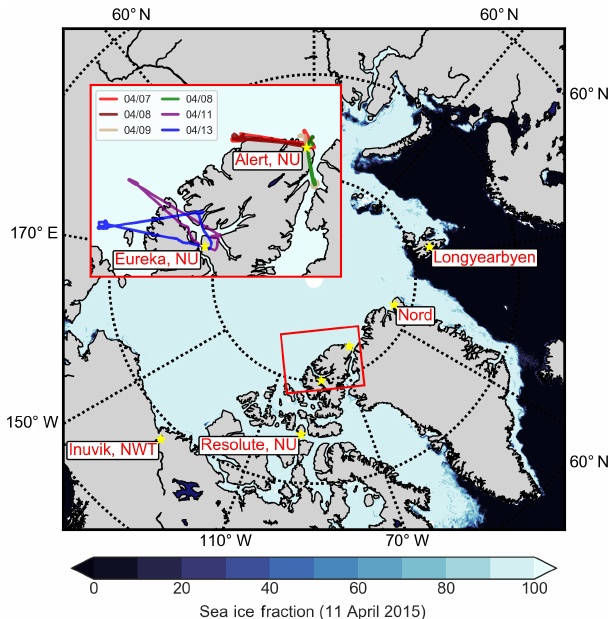
Figure 1. Map of the NETCARE 2015 campaign study area, show- ing sea ice concentrations on 11 April 2015 (Spreen et al., 2008). All stations along the NETCARE/PAMARCMiP 2015 track are shown with yellow stars (Longyearbyen, Svalbard; Alert, Nunavut; Eu- reka, Nunavut; Resolute Bay, Nunavut; and Inuvik, Northwest Ter- ritories). Parallels are shown in dashed circles at 60, 70 and 80 ◦ N. Inset: flight tracks from six flights during 7–13 April 2015 based in Alert and Eureka, Nunavut, which are the focus of this